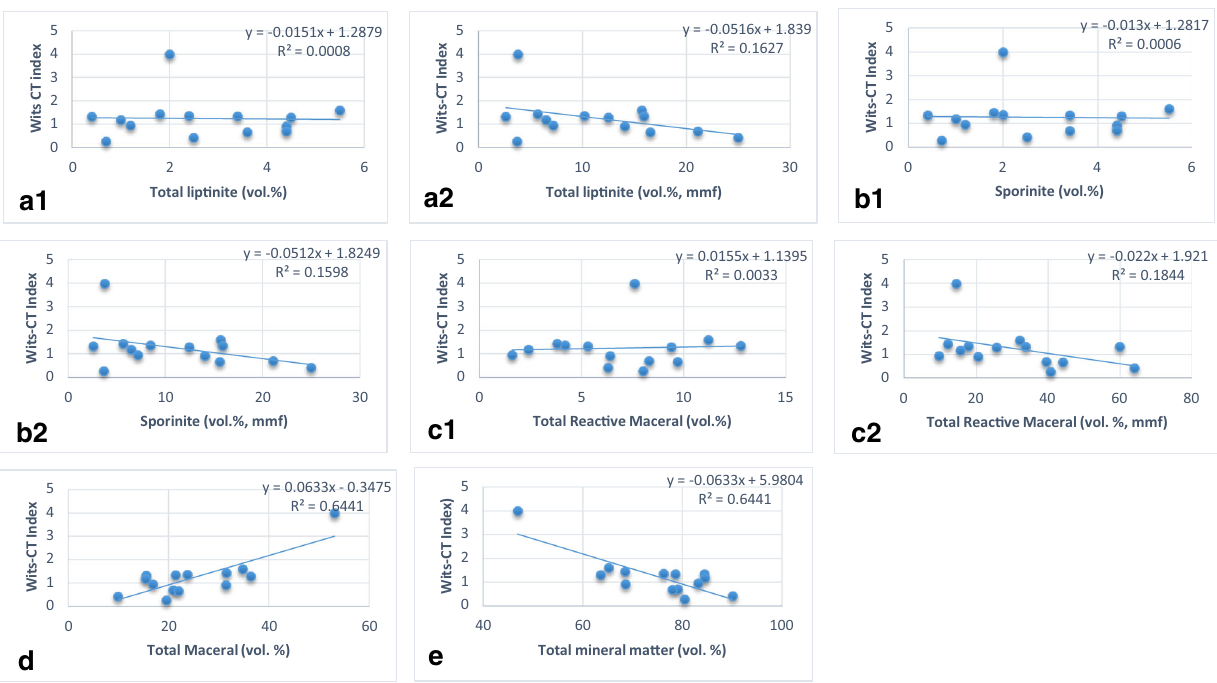
Fig. 16 Influence of liptinite, other macerals, petrographically observable mineral matter and its group on spontaneous combustion of coal- shales